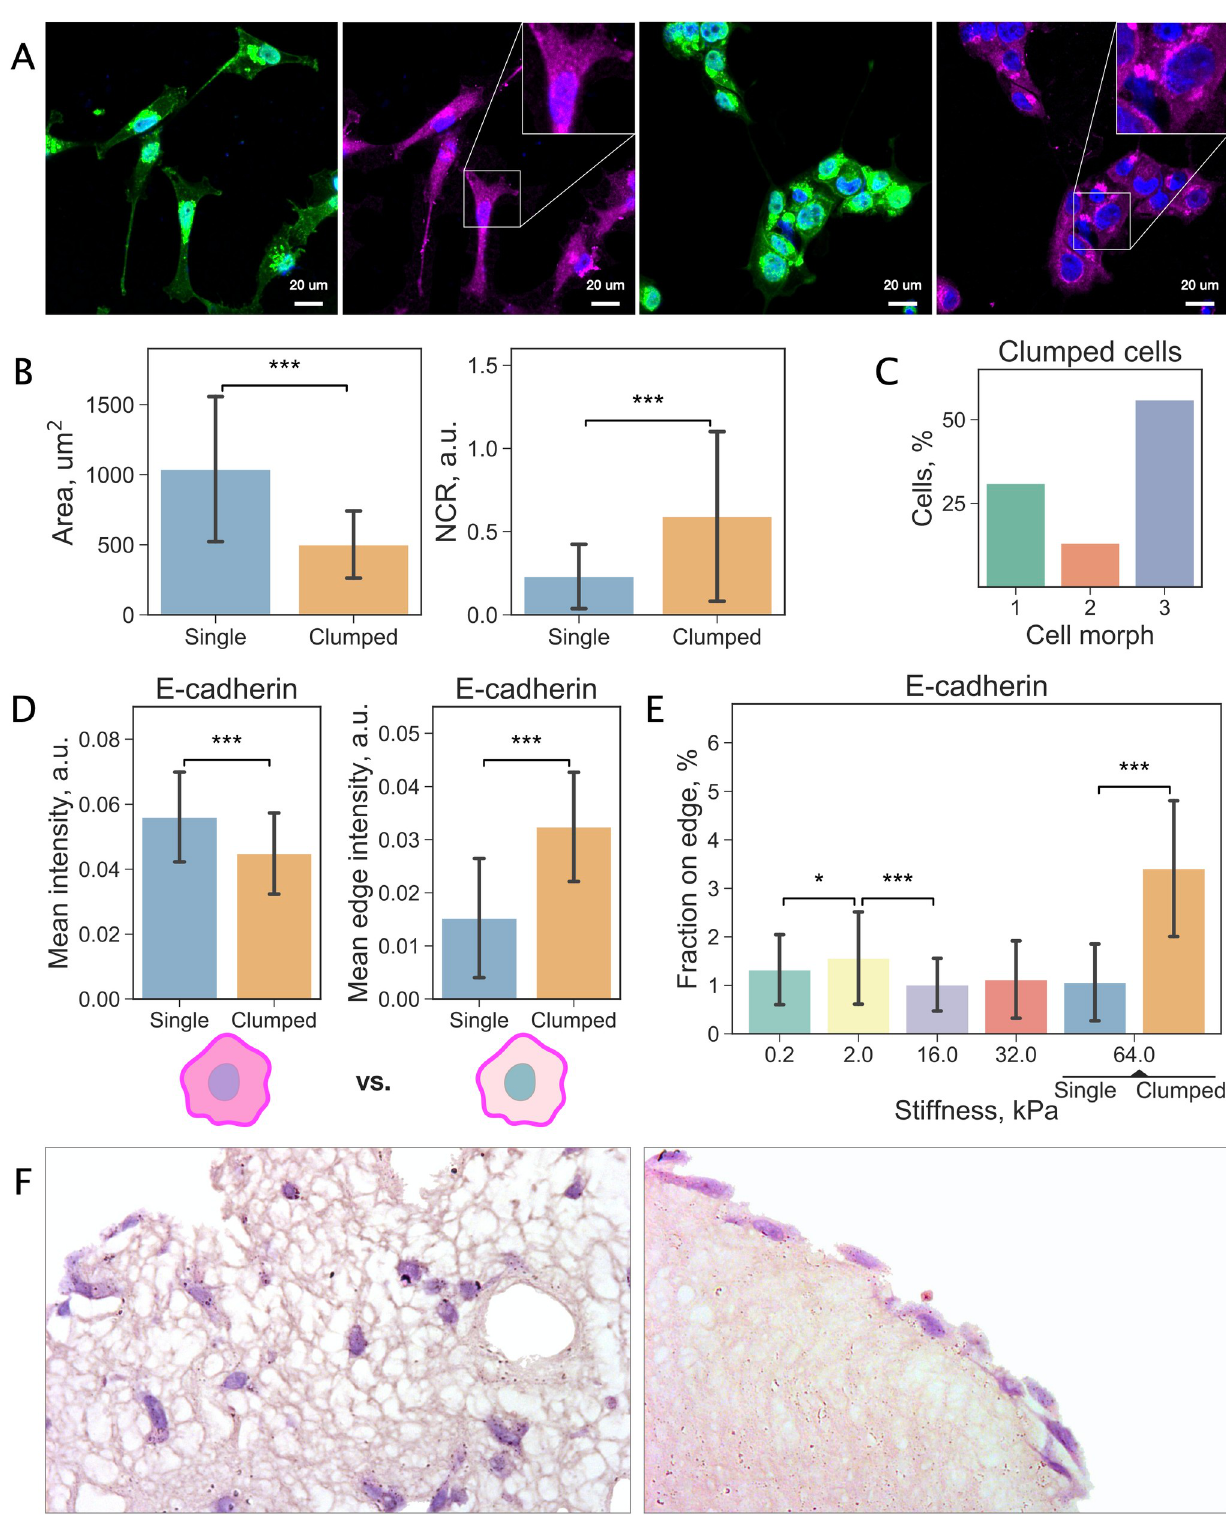
Fig 7. Comparison of individual and clustered cells cultured at 64 kPa. (a) Example images of individual and clumped cells cultured at 64 kPa. Cells stained with DAPI (blue) and WGA-FITC (green) to visualise cell nuclei and cytoplasm, and for E-cadherin (magenta). (b) Key differences between Single and Clumped cells. (c) Cell morph composition of Clumped cell population. (d) Mean intensity and mean edge intensity of E-cadherin in Single and